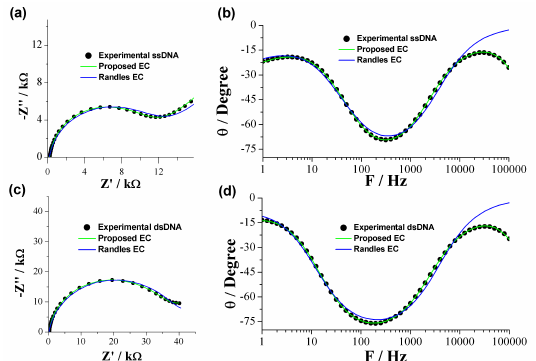
Figure 6. EIS Nyquist and Bode plots of the HPV-16 DNA / Au electrode. ( a , b ) ssDNA, ( c , d )